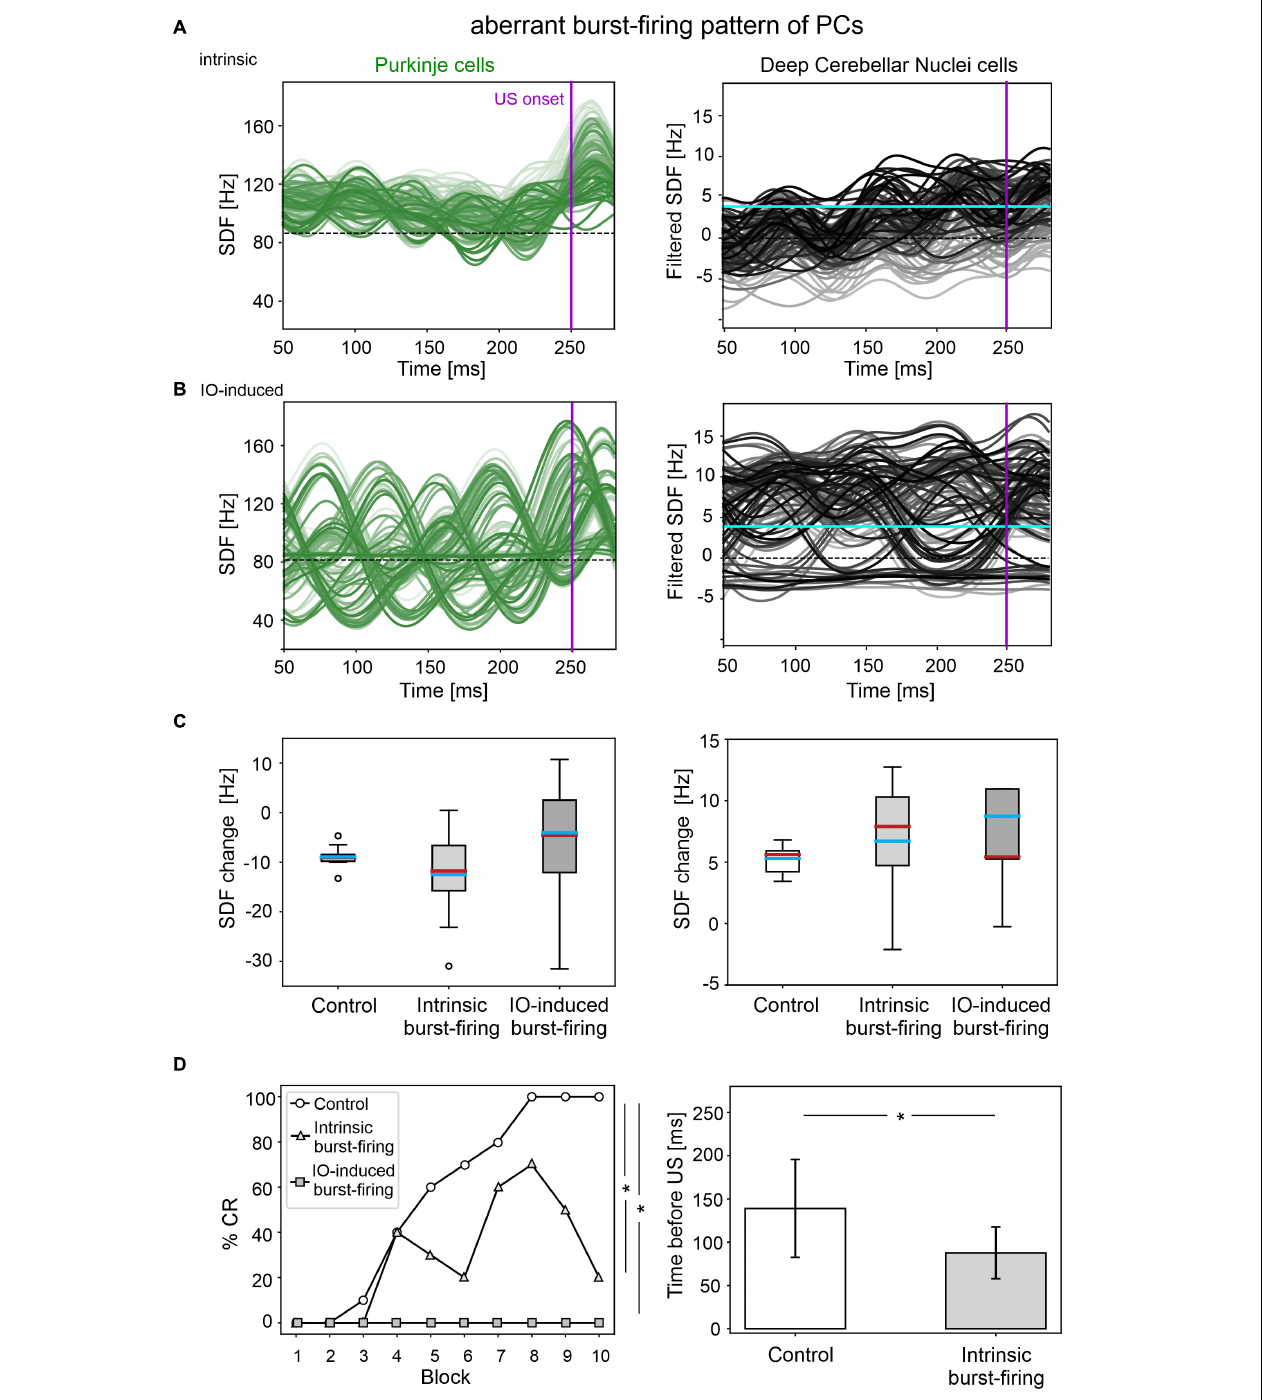
FIGURE 5 | EBCC simulations in the case of aberrant burst-firing pattern of PCs. SDF in PC population and DCN motor output (averaging across cell SDFs) for each trial (0 ms is aligned with the CS onset), with intrinsic PC burst-firing (A) and IO-induced PC burst-firing (B) . Increasing darkness of the lines corresponds subsequent trials (the lightest is the first trial, the darkest is the last trial). Dashed horizontal line indicates baseline activity, solid horizontal cyan line (right panels) represents CR threshold. Purple vertical line corresponds to US onset time. (C) SDF change in PC (left) and DCN (right) populations from the 10 trials in the last block, computed in the CR window with respect to SDF value in the first 100 ms from CS onset; * corresponds to p < 0.01 in the Wilcoxon test. (D) Behavioral EBCC outcome, i.e., %CR along trial blocks (left panel), and CR timing with respect to US onset (right panel), compared to the control condition. Error bars indicate the standard deviation. CR onset is not represented for the IO-induced PC burst-firing case, as no CRs were acquired during the simulation. * corresponds to p < 0.01 in the McNemar’s test for %CR and the Wilcoxon test for the CR onset timing.